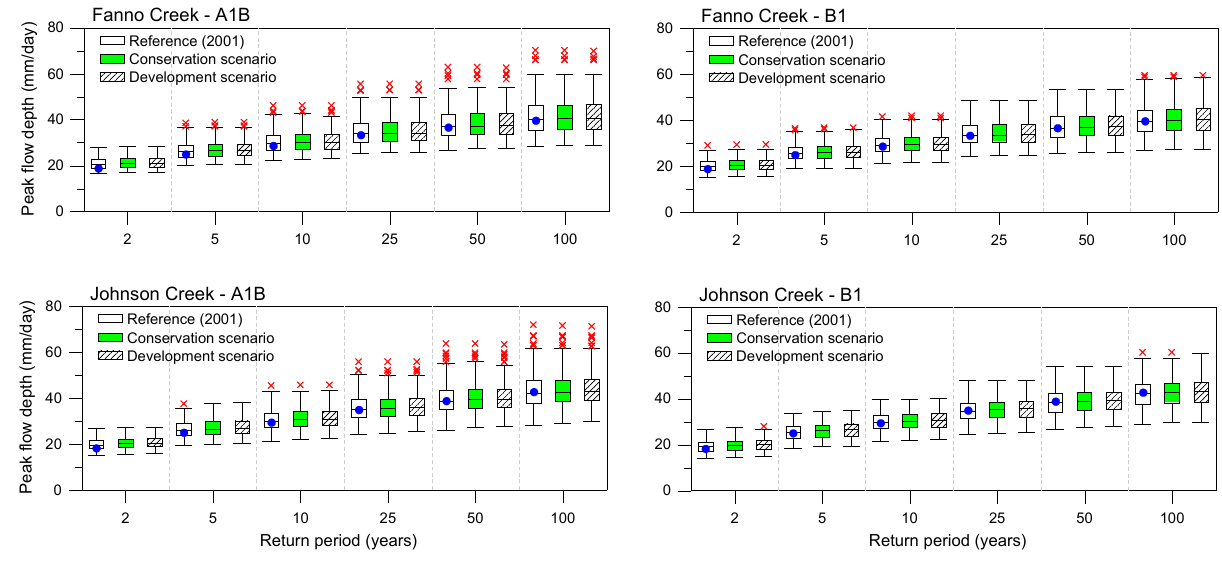
Fig. 8. Variation of flood frequency flows by combination of land use change and climate change scenarios with recurrence intervals of 2, 5, 10, 25, 50, and 100 years for the 2050s with respect to the reference period of 1960–1989. The blue dot indicates flood frequency using observed climate data, and symbol (x) indicates outliers.